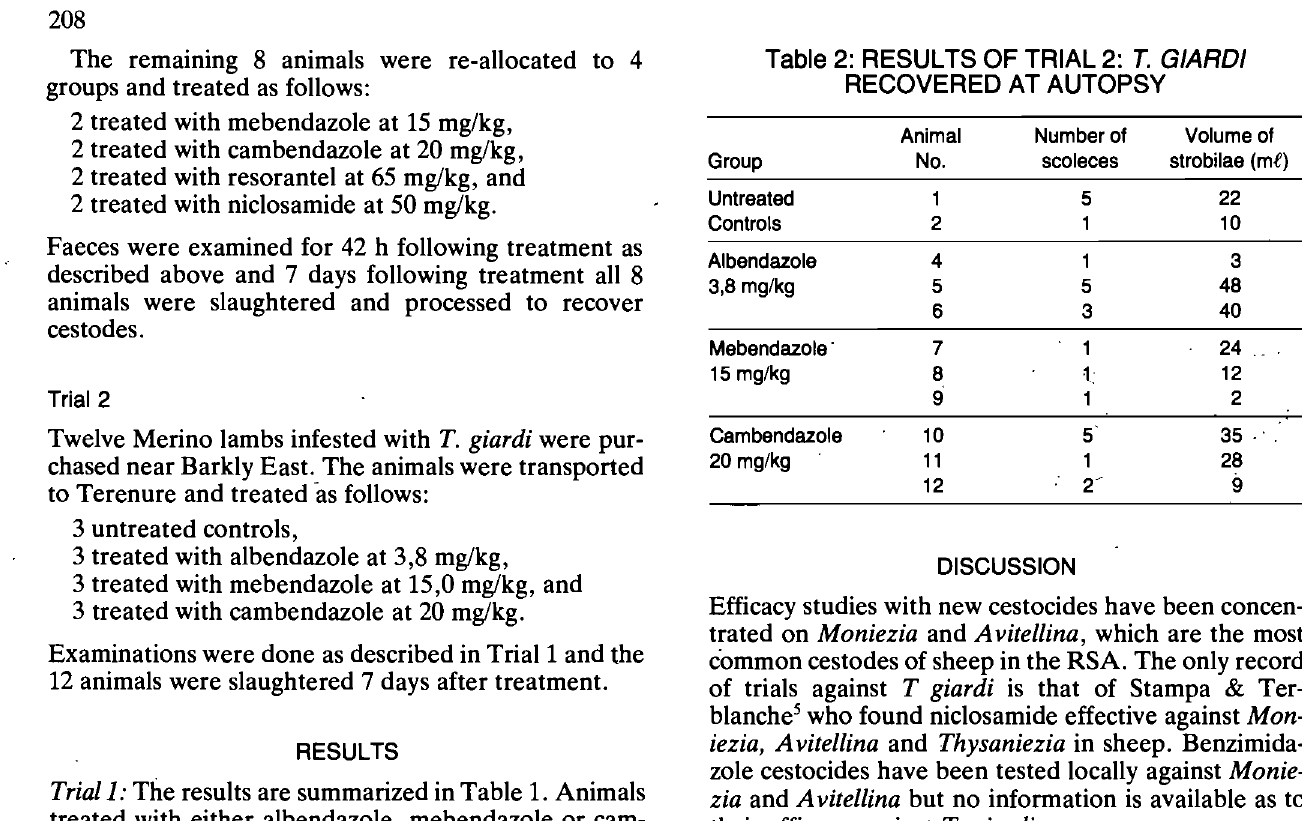
Table 1 : RESULTS OF TRIAL 1: T. GIARDI RECOVERED AT AUTOPSY Animal